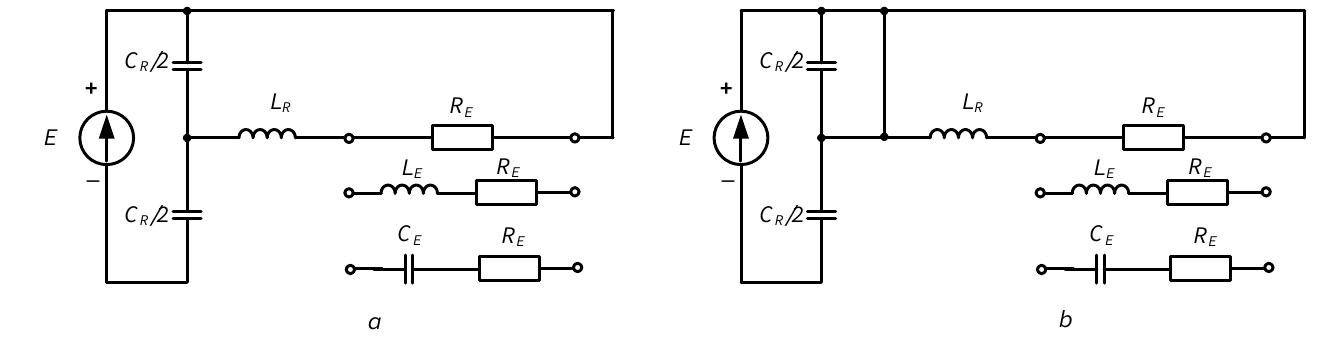
Figure 3. Equivalent scheme for one half-period of the operation of RI with DE ( a ) with power consumption from the power source (0 − ϑ d ); ( b ) without power consumption from the power source ( ϑ d − π ).